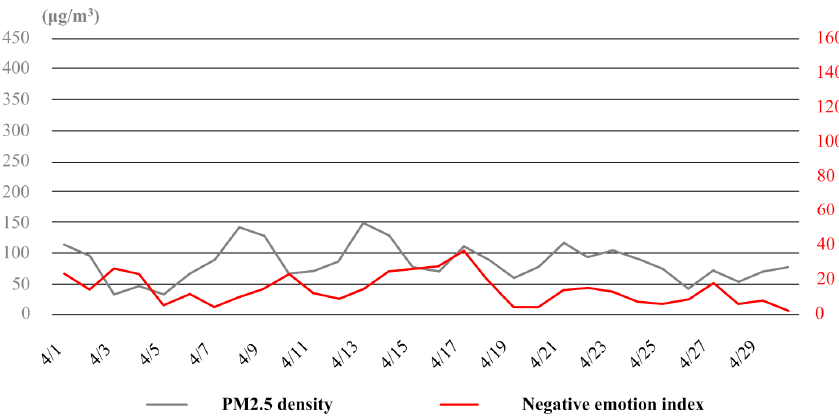
Figure 10. The variation curves of PM2.5 density and negative emotion index in April.